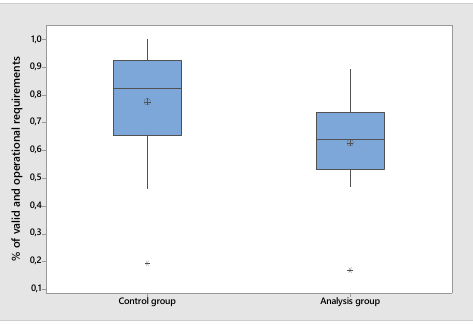
Figure 5. Boxplot of the fraction of valid and operational requirements produced by each subject.